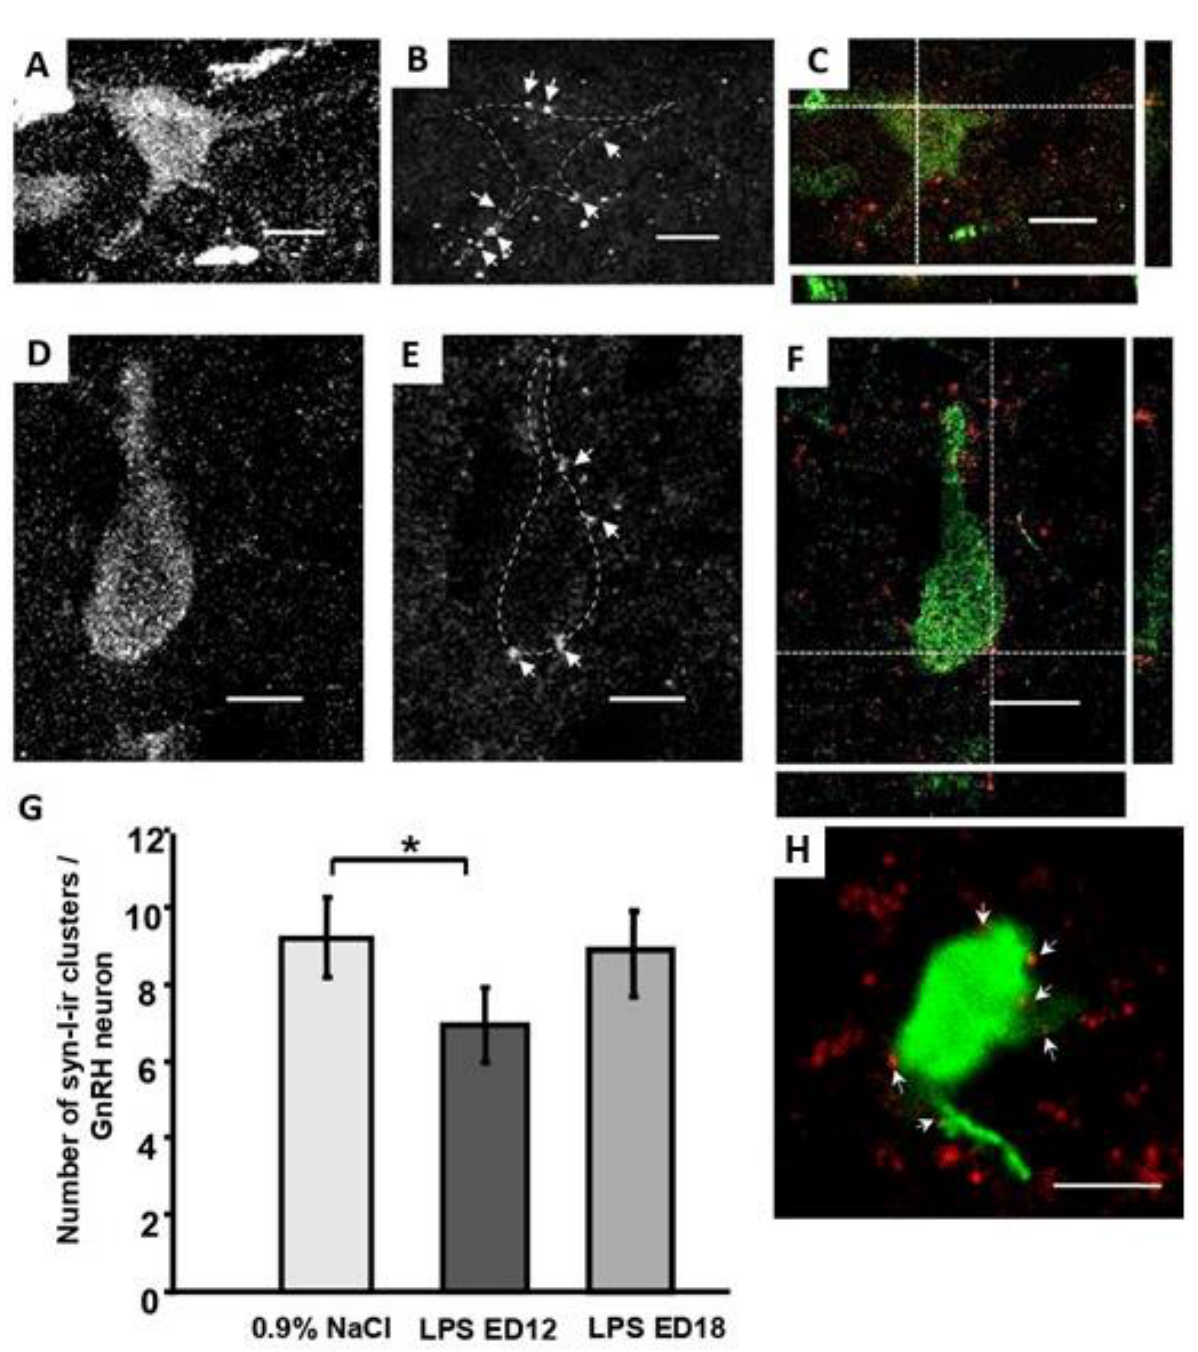
Figure 2. Synapsin-1-immunoreactive (syn 1-ir) clusters on the gonadotropin-releasing hormone (GnRH) neurons of males on PND80 exposed on ED12 to ( A – C ) 0.9% NaCl (control) and ( D – F ) lipopolysaccharide (LPS, 50 μg/kg). Maximum projection of confocal microphotograph stacks of neurons stained with anti-GnRH ( A , D ) and anti-synapsin-1 ( B , E ) antibodies. Neurons are outlined with dotted lines; white arrows mark the syn 1-ir clusters. Merge ( C , F ): orthogonal projections of single optical sections demonstrate the close apposition of syn 1-ir clusters with the GnRH neurons. Scale bar = 20 μm ( A – C ), 10 μm ( D – F , H ). ( G ) Number of syn 1-ir clusters in close apposition with the GnRH neurons of males exposed to saline or LPS on ED12 or ED18 (n = 10 animals per group). M ± SEM, * p < 0.05 compared with the control group. ( H ) Representative microphotograph of GnRH neuron of males treated with LPS on ED18.